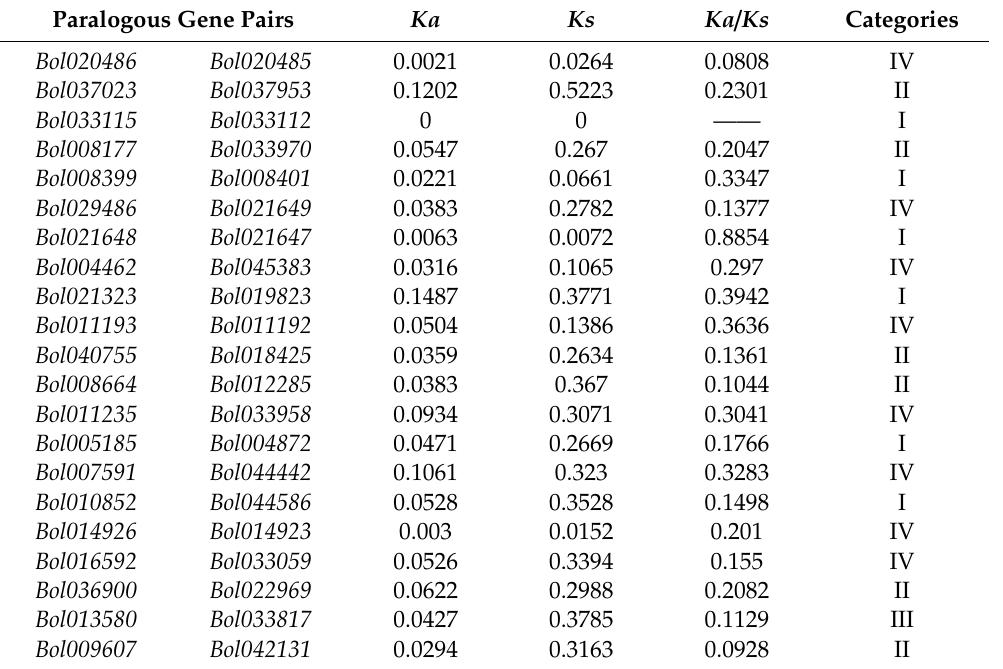
Table 1. The synonymous substitution rate (Ka) and nonsynonymous substitution rate (Ks) between paralogous PG gene pairs of B. oleracea . Gene expression patterns were categorized into four categories (I, II, III, and